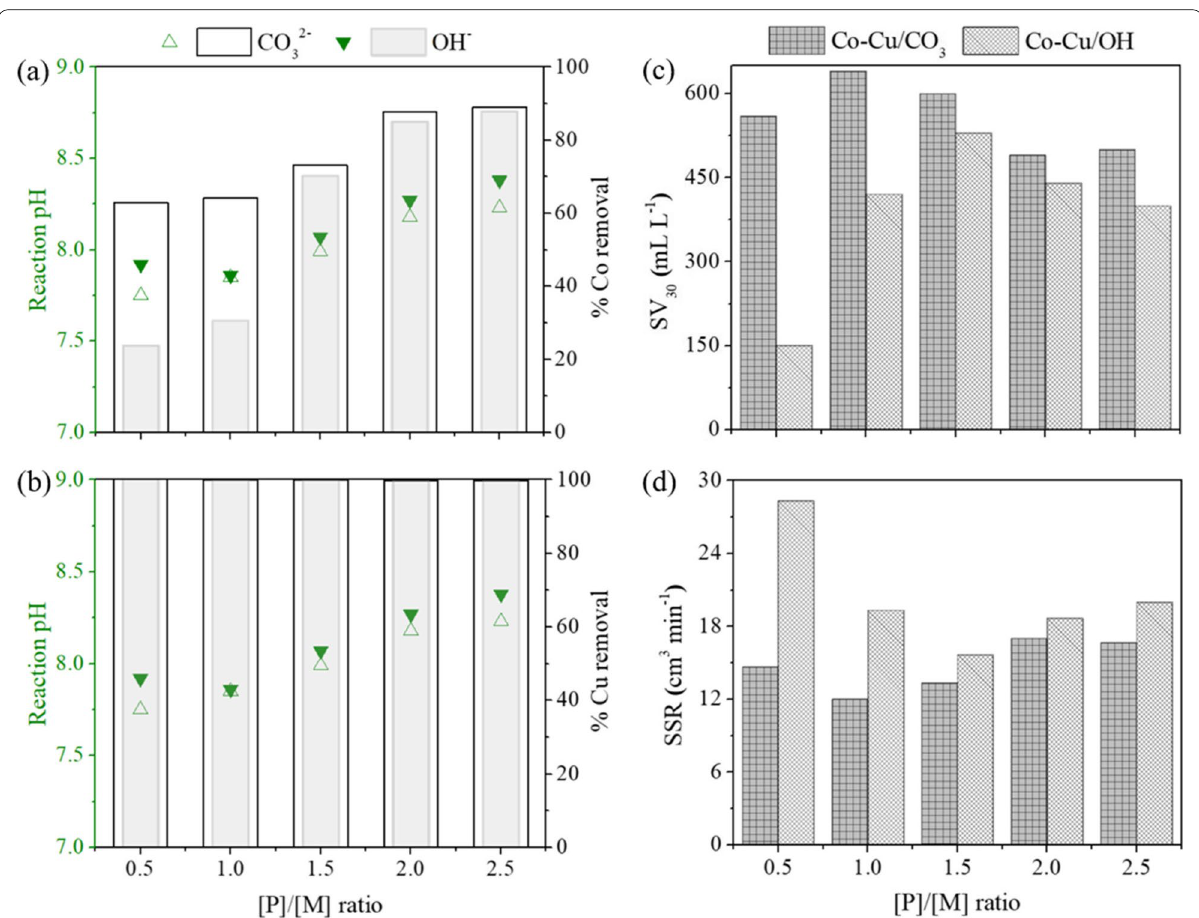
Fig. 11 Removal efficiency of ( a ) cobalt and ( b ) copper, ( c ) sludge volume at 30 min and ( d ) sludge settling rate in the co‑contaminated system at different [P]/[M] ratio using different